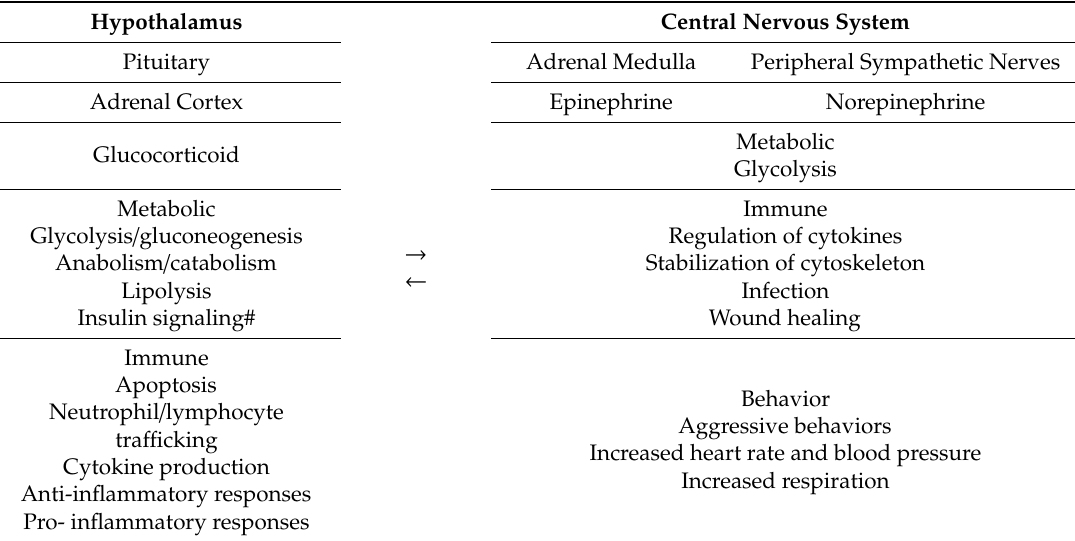
Table 1. Scheme of interactions changing metabolic and immunological